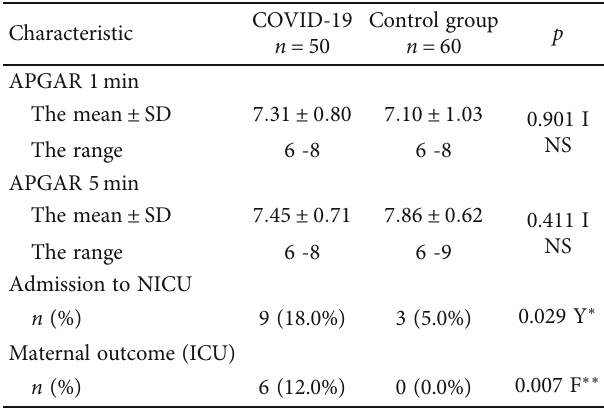
Table 4: Maternal and fetal outcome contrasted between COVID- 19 and control group.